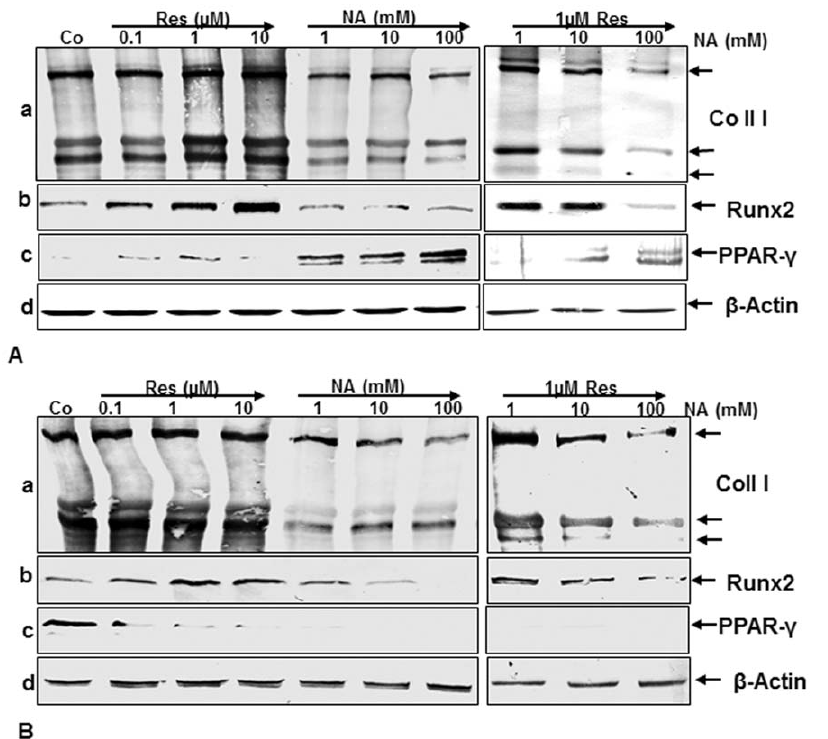
Figure 3. Effect of resveratrol or/and nicotinamide on extracellular matrix, Runx2 and PPAR- c expression during osteogenesis of MSC and pre-osteoblastic cells in high-density cultures. Whole cell lysates (500 ng of protein per lane) were probed with antibodies for collagen type I (a), for the osteogenic specific transcription factor Runx2 (b) and for the adipogenic specific transcription factor PPAR- c (c) in MSC (A) and in pre-osteoblastic cells in high-density culture (B). Cultures were treated with 0.1, 1 and 10 m M resveratrol alone, or with 1, 10 and 100 mM nicotinamide alone or pre-treated with 1 m M resveratrol for 4 hours and then co-treated with 1, 10, 100 mM nicotinamide or left untreated for 2 weeks with osteogenic induction medium in high-density cultures. Untreated cultures (without resveratrol or nicotinamide) produced collagen type I (a, A–B) and Runx2 (b, A–B) in both cultures. Incubation with nicotinamide reduced collagen type I and Runx2 production and increased the expression of PPAR- c in a concentration dependent manner in MSC-cultures (c, A) and decreased the expression of PPAR- c in a concentration dependent manner in pre-osteoblastic cultures (III, B). However, pre-treatment with resveratrol inhibited the adverse effects of nicotinamide and the osteoblasts produced large amounts of collagen type I and Runx2. Synthesis of the housekeeping protein b -actin was unaffected (d, A–B).